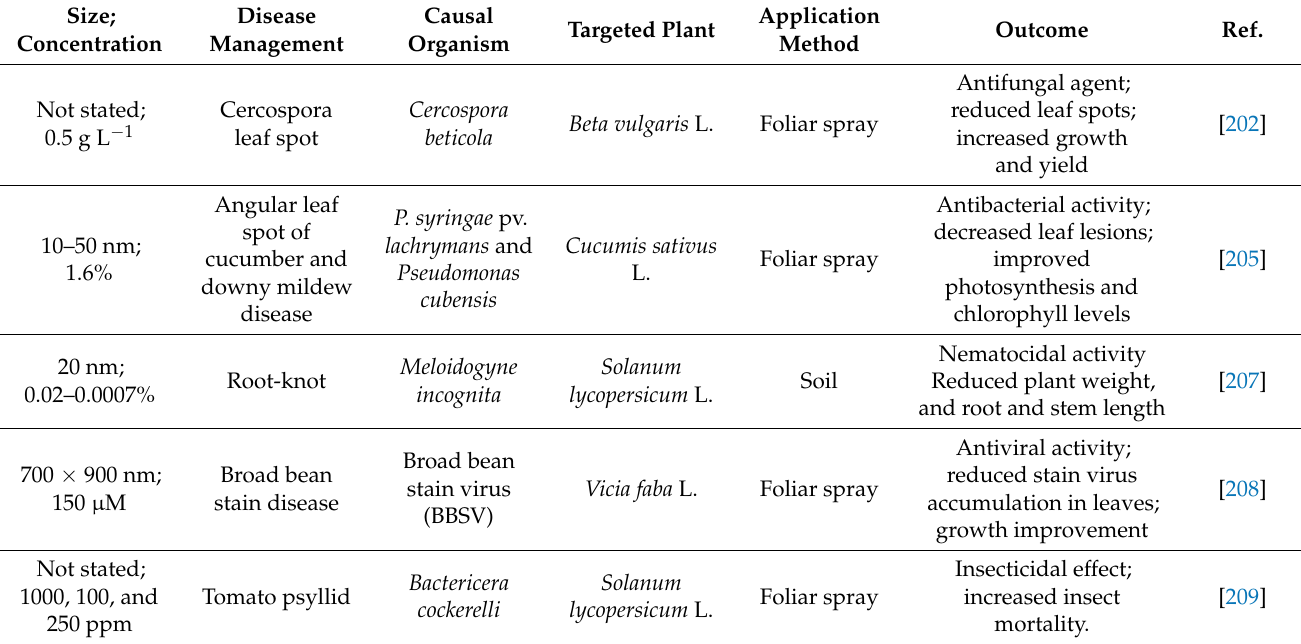
Table 10. Beneficial application of nTiO 2 on plant disease